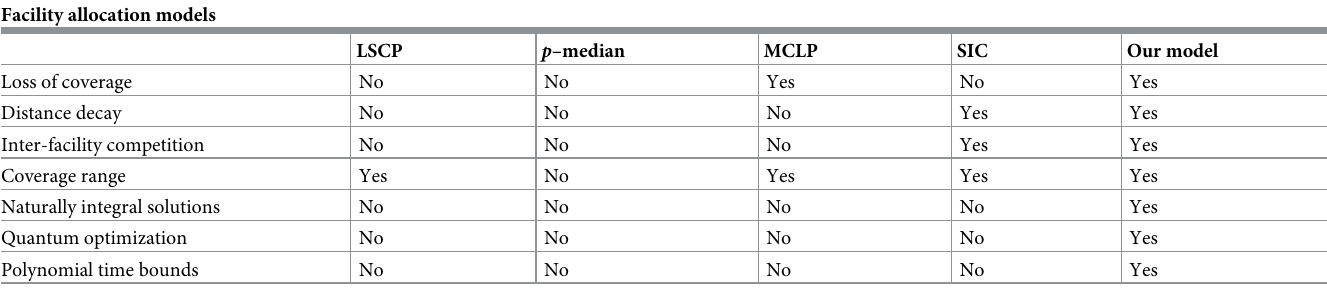
Table 5. The summary of facility allocation